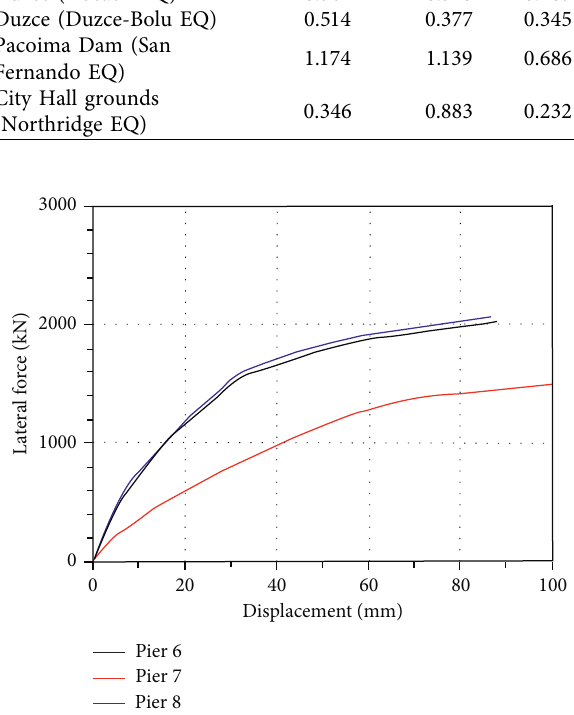
Table 1: Peak ground acceleration of the selected records. Station